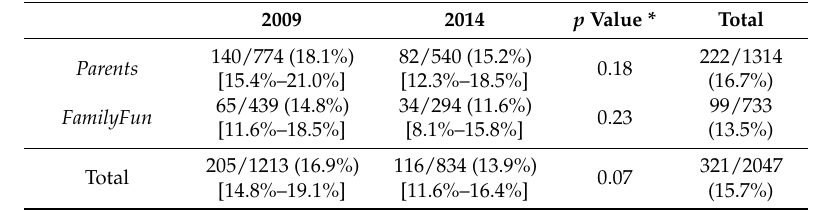
Table 1. Proportion of advertisements with non-adherence for American Academy of Pediatrics (AAP) recommendations in the top two parenting